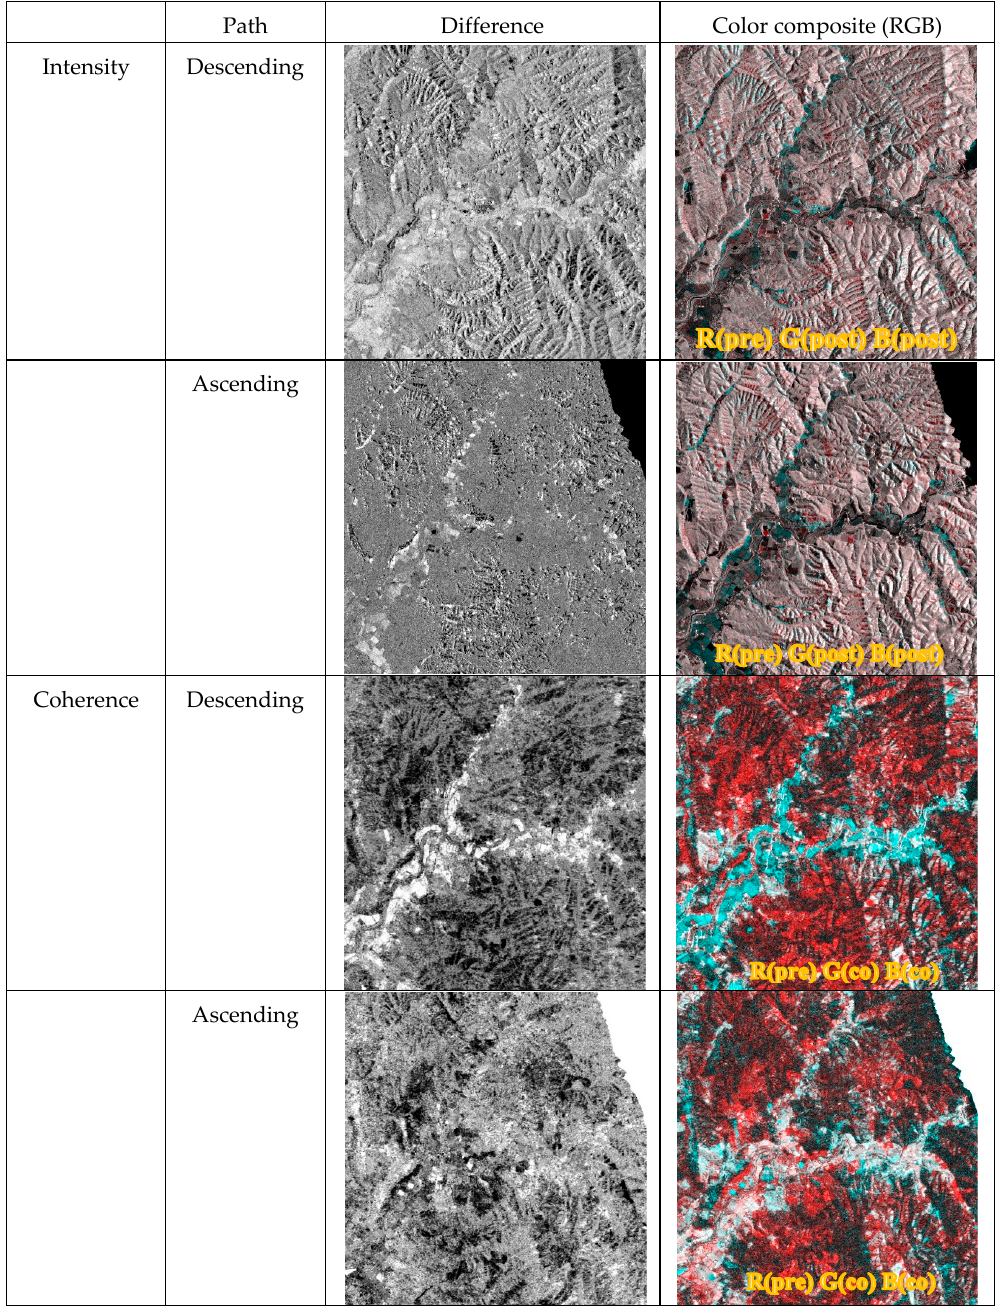
Figure 6. The differences in synthetic aperture radar (SAR) intensities and coherence and the color composite map of the study area. The intensity/coherence differences were calculated by subtracting the pre-event values from the post-event/co-event